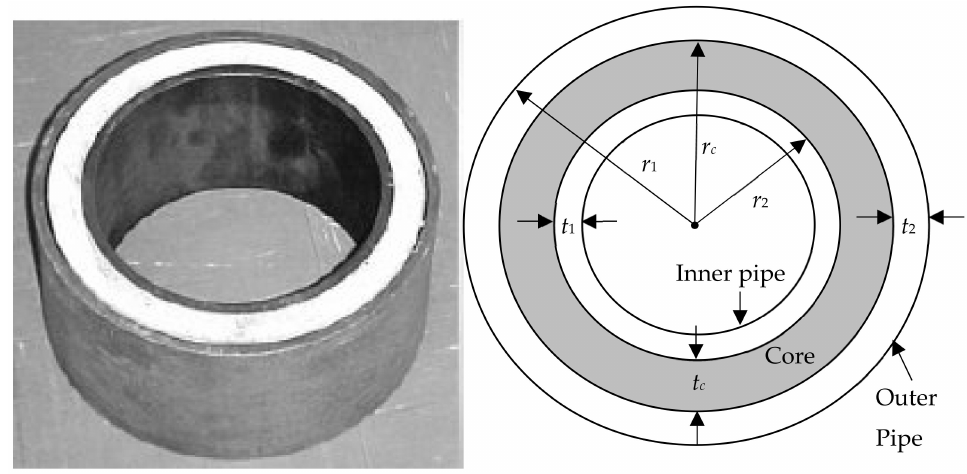
Figure 1. Illustration of SP specimen and geometry